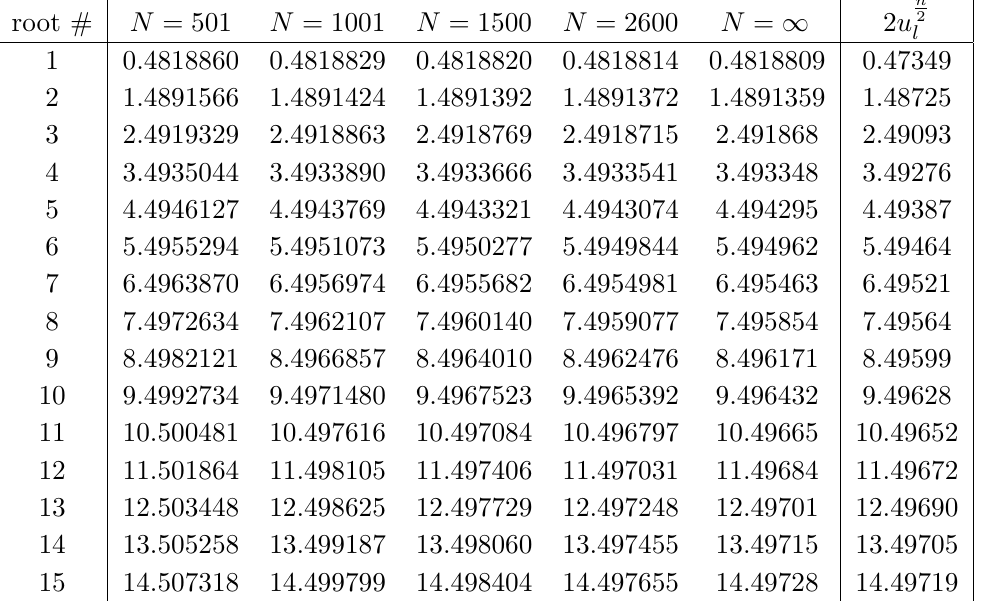
Table 5 . Numerical values of 2 N of the discretized operator T ( N ) ( (cid:22) ) for n = 4, j = m = 0. The column \ N = 1 " was obtained by interpolating the results for (cid:12)nite N . The entries in the last column were calculated by using the asymptotic formula (A.2) truncated at the (cid:12)rst non-zero term in the